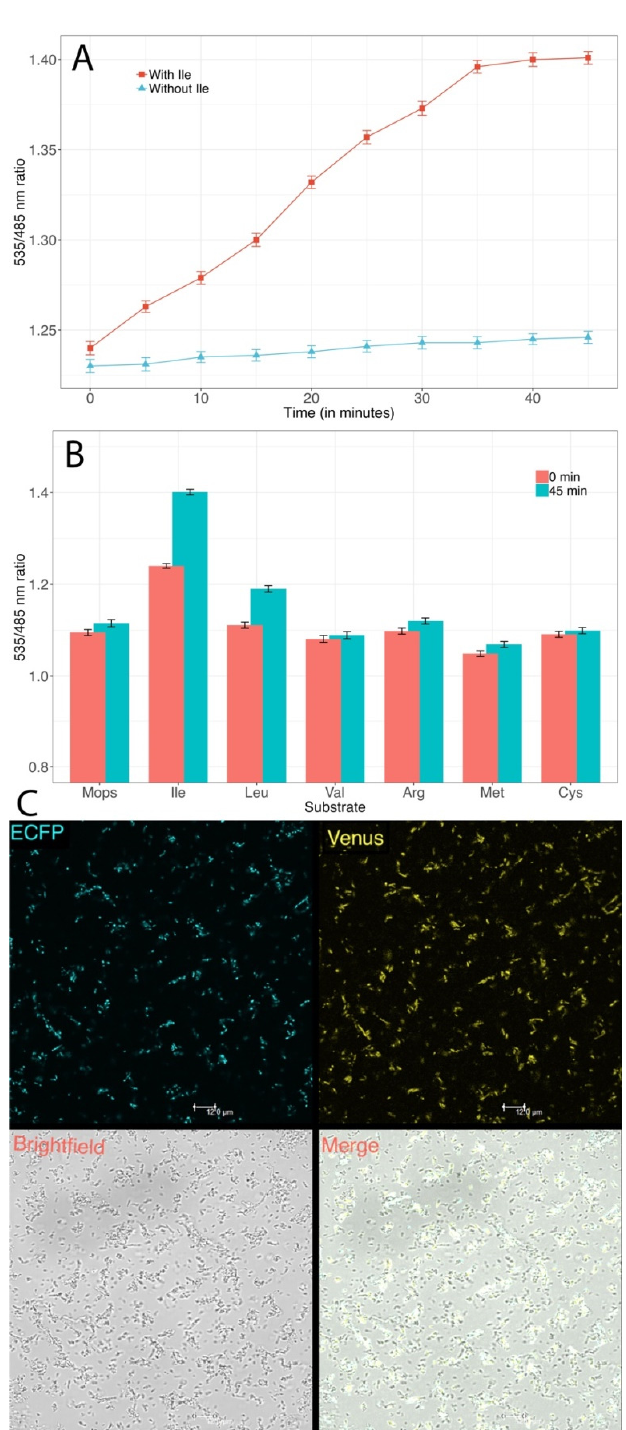
Figure 6. Real-time monitoring of isoleucine in bacterial cells. ( A ) Change in FRET ratio of the GEII sensor with respect to time when exposed to 10 mM isoleucine. The change is insignificant in the absence of isoleucine. Isoleucine uptake by bacterial cells took about 30–40 min to reach saturation levels. The sensor protein concentration of 0.20 mg/mL was used for the experiment. ( B ) FRET ratio change of expressed GEII sensor in E. coli cells after 45 min of exposure to 10 mM each of isoleucine, leucine, valine, methionine, arginine, and cysteine. Mops was used for the control experiment. As is clear from the maximum FRET ratio change with respect to isoleucine, GEII retains its specificity in bacterial cells as well. ( C ) Confocal images of the expressed GEII sensor in E. coli bacterial cells. Scale bar: 12 μ M.